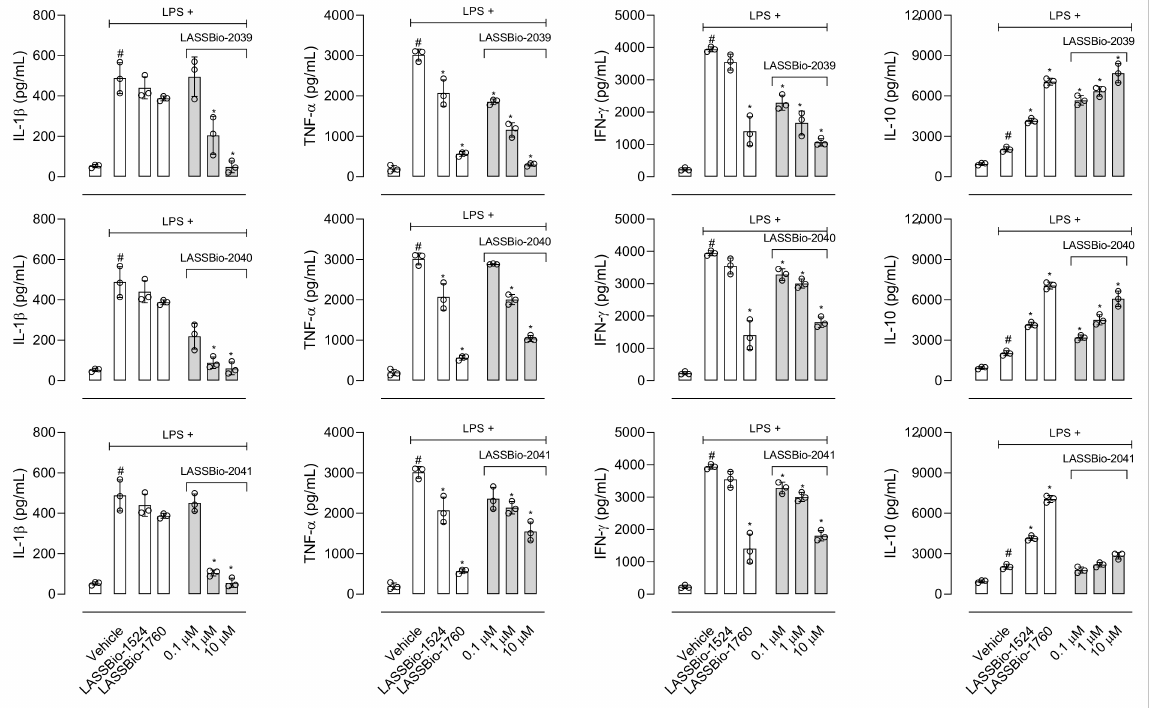
Figure 8. Effect of LASSBios in interleukin-1 β (IL-1 β ), tumor necrosis factor- α (TNF- α ), interferon- γ (IFN- γ ) and interleukin-10 (IL-10) produced by J774.A1 cells line. Cells were incubated with vehicle, LASSBio-1524 or LASSBio-1760 (at 30 µ M), or LASSBios (0.1, 1 or 10 µ M) and after 1 h were activated with LPS (1 µ g/mL). Results are expressed as media ± SD ( n = 3). Where no error bar is shown it is because it is smaller than the symbol. Statistical significance was calculated in GraphPad Prism 8.0 (San Diego, CA, USA) using analyses of variance (ANOVA) followed by Tukey post-test with p < 0.01 (#) when comparing LPS-activated cells treated with vehicle and non-activated cells treated with vehicle. p < 0.01 (*) when comparing LPS-activated cells treated with LASSBios and LPS-activated cells treated with vehicle. Data for the original compounds (LASSBio-1524 and LASSBio-1760) are original, independent duplicates of past results and have not been published